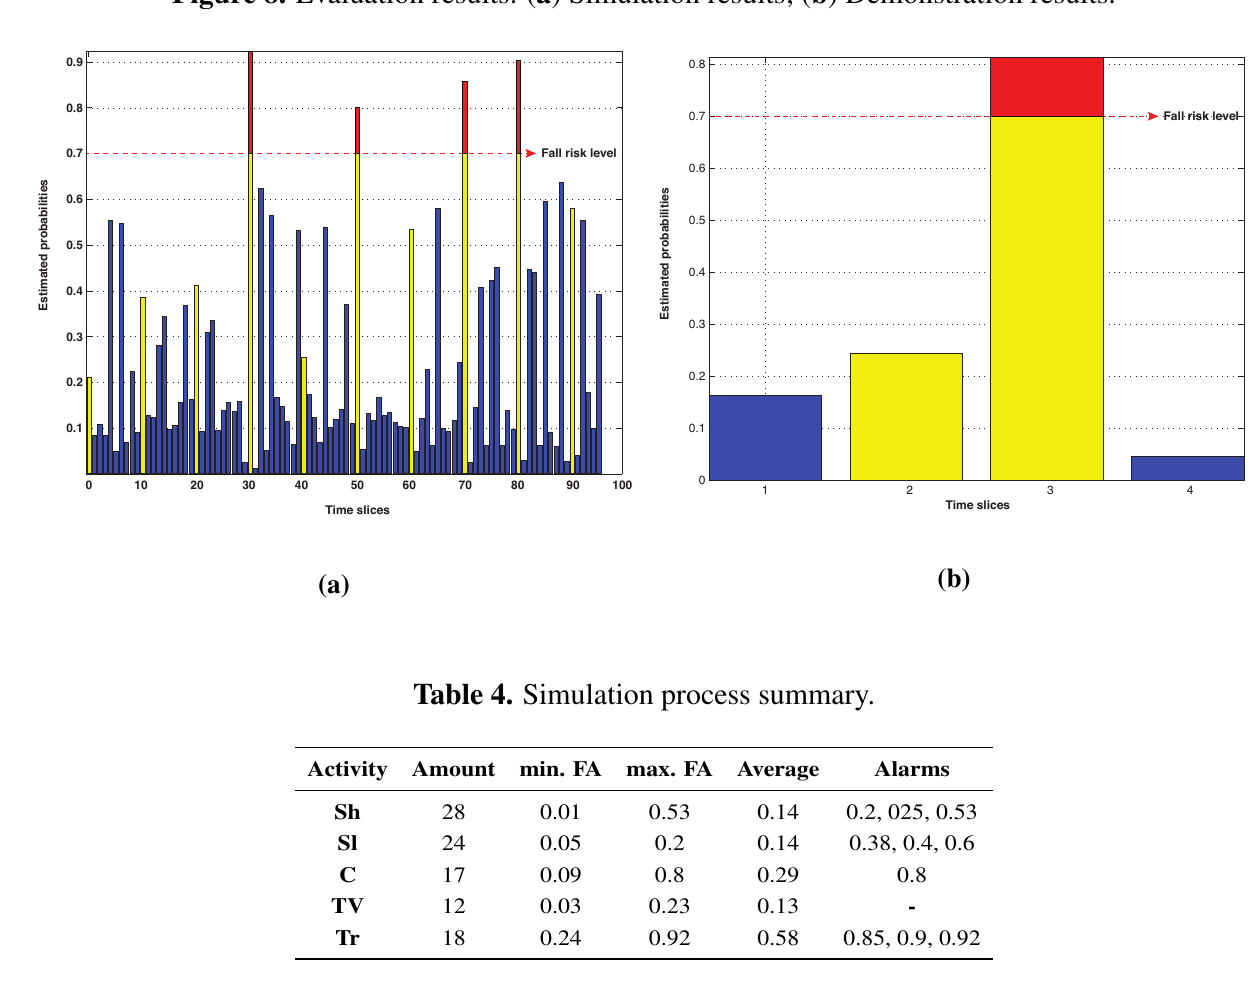
Figure 8. Evaluation results. ( a ) Simulation results; ( b ) Demonstration results.